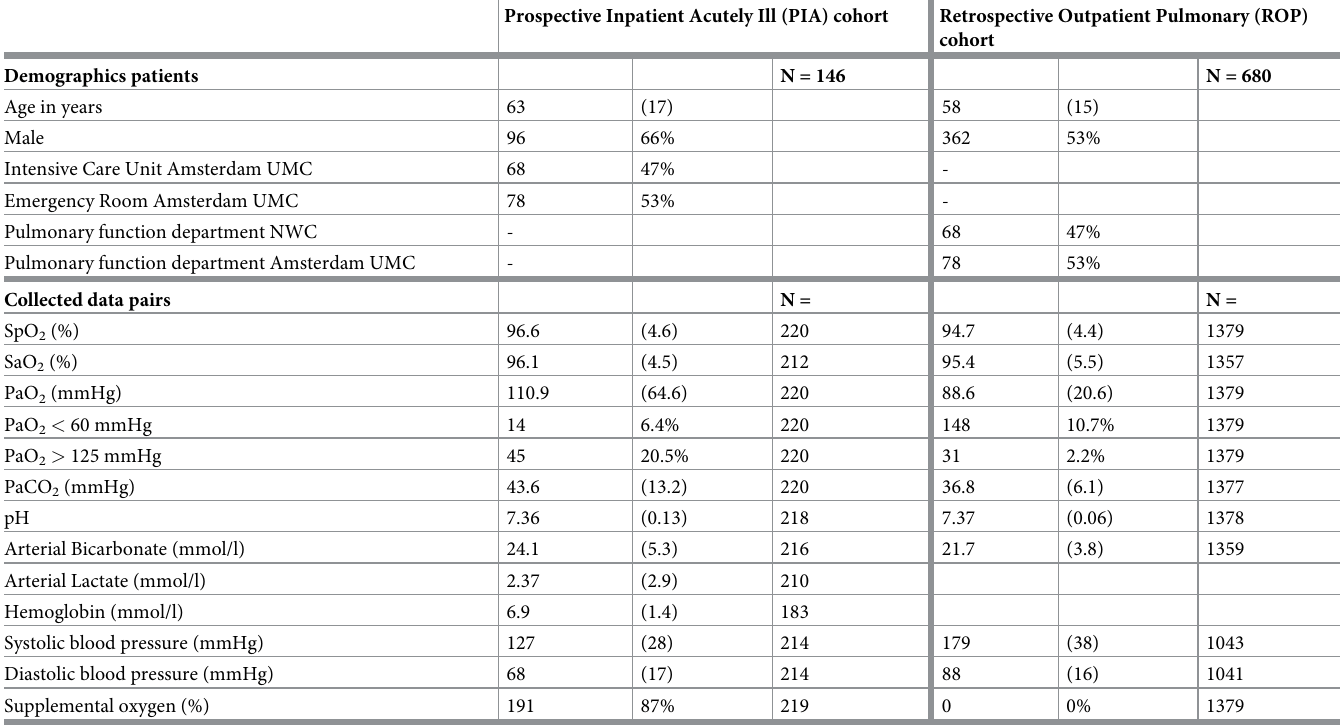
Table 1. Demographics of included patients and data pairs characteristics.